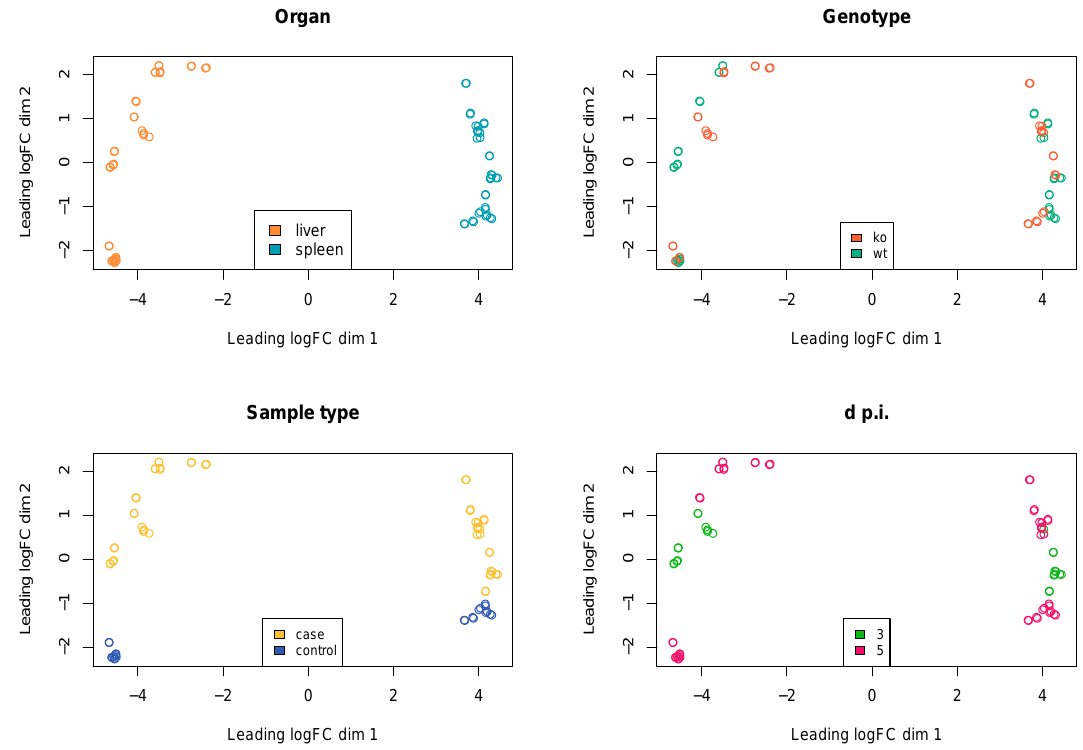
Figure A1. Multidimensional Scaling (MDS) plots showing main differences between individual samples according to the four features these present: organ procedence, genotype, sample type (mock infection or MHV-infected) and days post